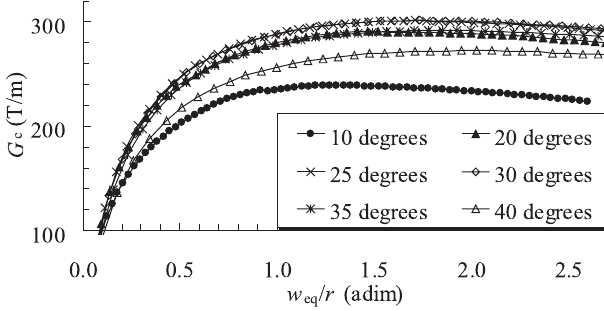
FIG. 16. Critical gradient versus equivalent sector width (41) for different angular widths of the sectors for an aperture radius of 30 mm.